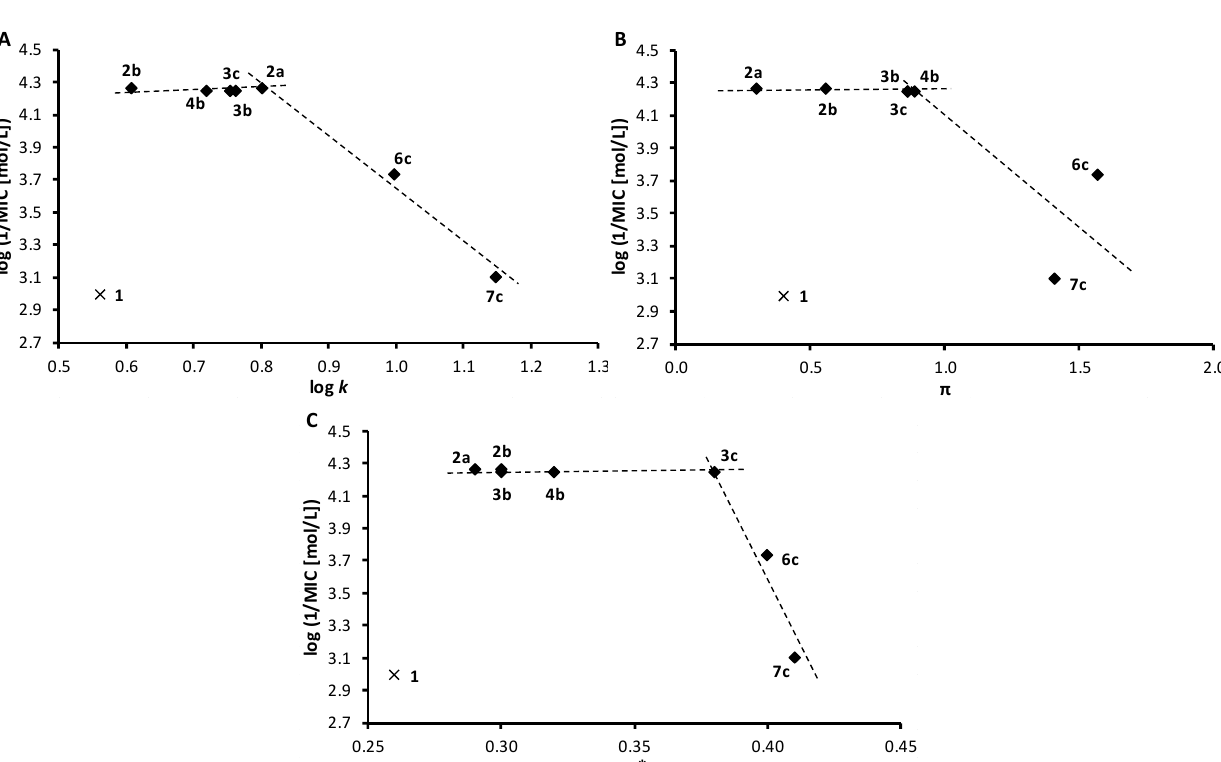
Figure 2. Dependence of in vitro antimycobacterial activity against Mycobacterium avium subsp. paratuberculosis log(1/MIC [mol/L]) on lipophilicity expressed as log k ( A )